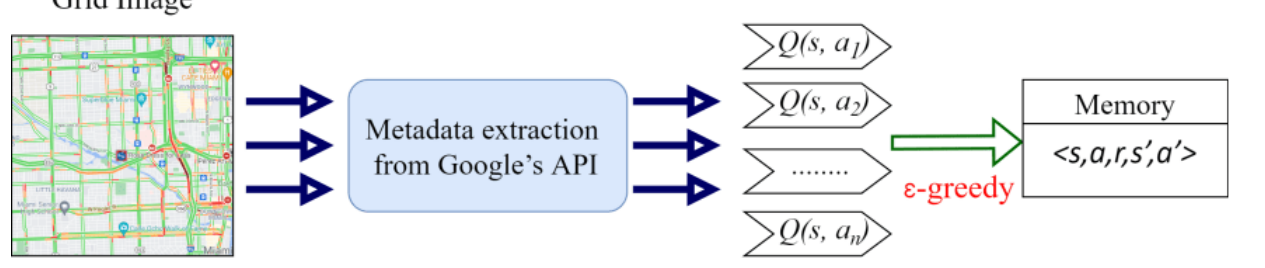
Figure 4. Illustration of the data extraction mechanism in this work.